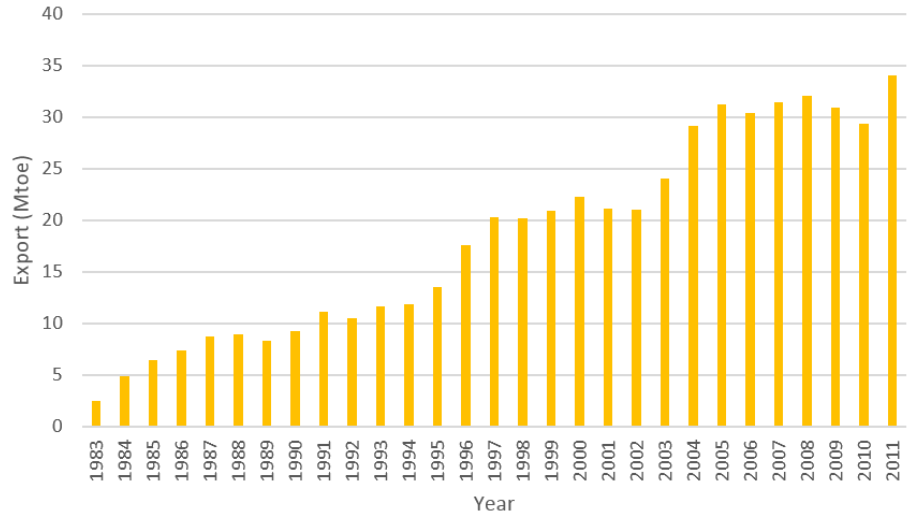
Figure 23. LNG export in Malaysia from 1983 to 2011.